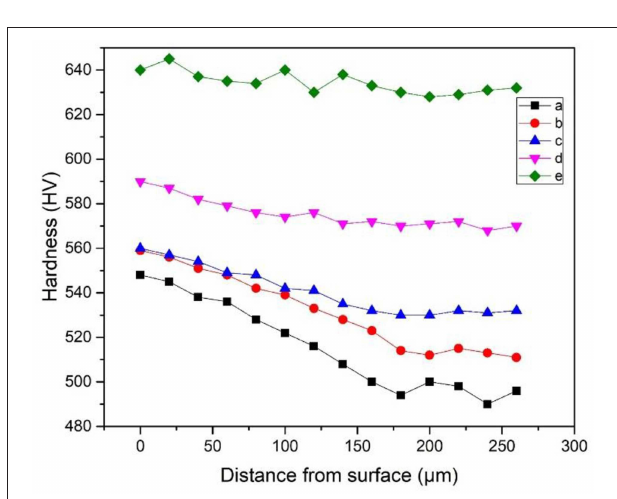
FIGURE 8 | Microhardness HV distribution in the worn subsurface of the